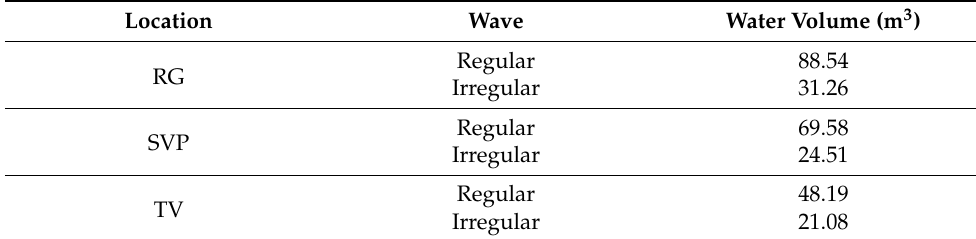
Table 4. Total volume of water accumulated in the reservoir for each